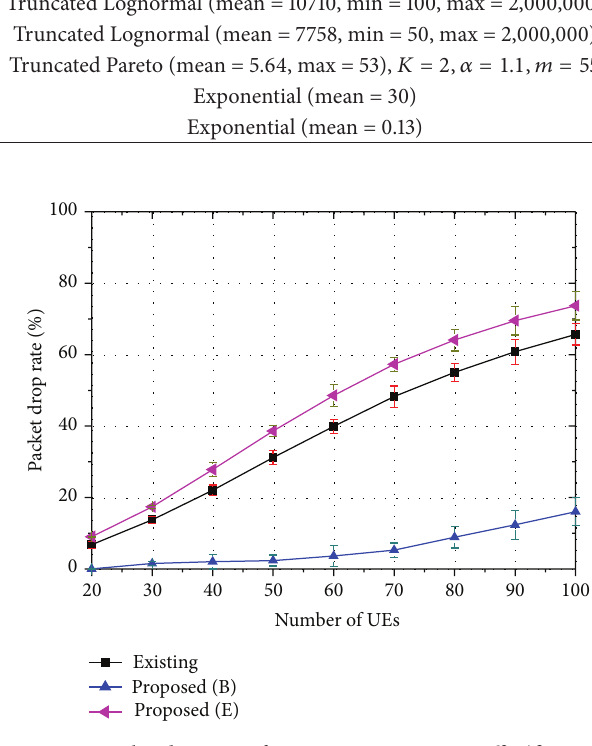
Figure 5: Packet drop rate of 16-viewpoint 3D A/V traffic ( 𝛽 = 0.9 ).